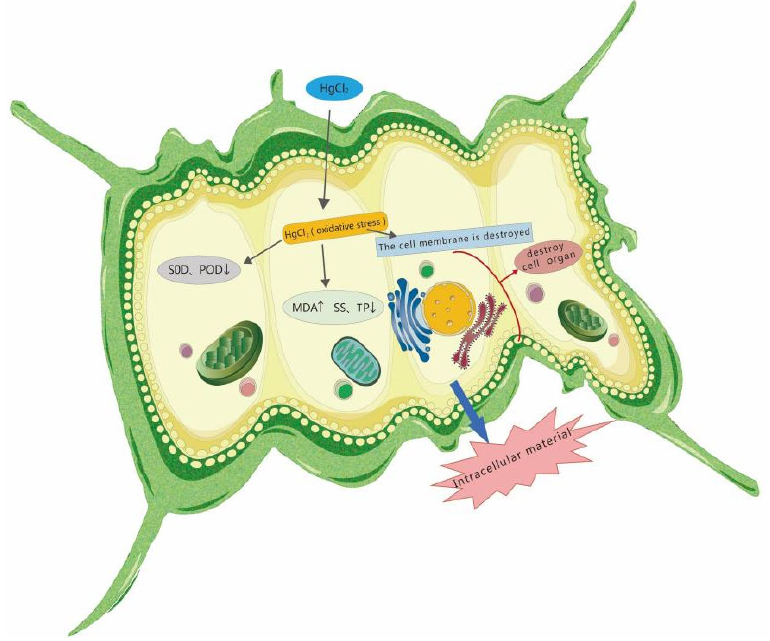
Figure 8. Mechanisms of toxic effects of HgCl 2 on Scenedesmus quadricauda .